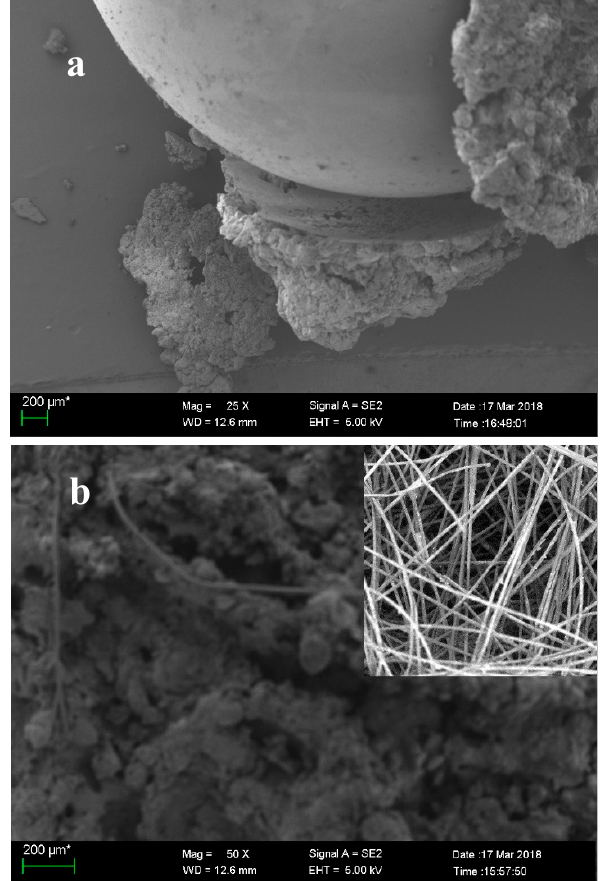
Figure 3. SEM pictures of the clogging materials: ( a ) the surface of glass spheres and ( b ) nonwoven geotextile fibers (upper-right corner is the SEM pictures of nonwoven geotextile before the experiment). The hydraulic conductivity changes in group G and N during the continuous experiment over 220 days are shown in Figure